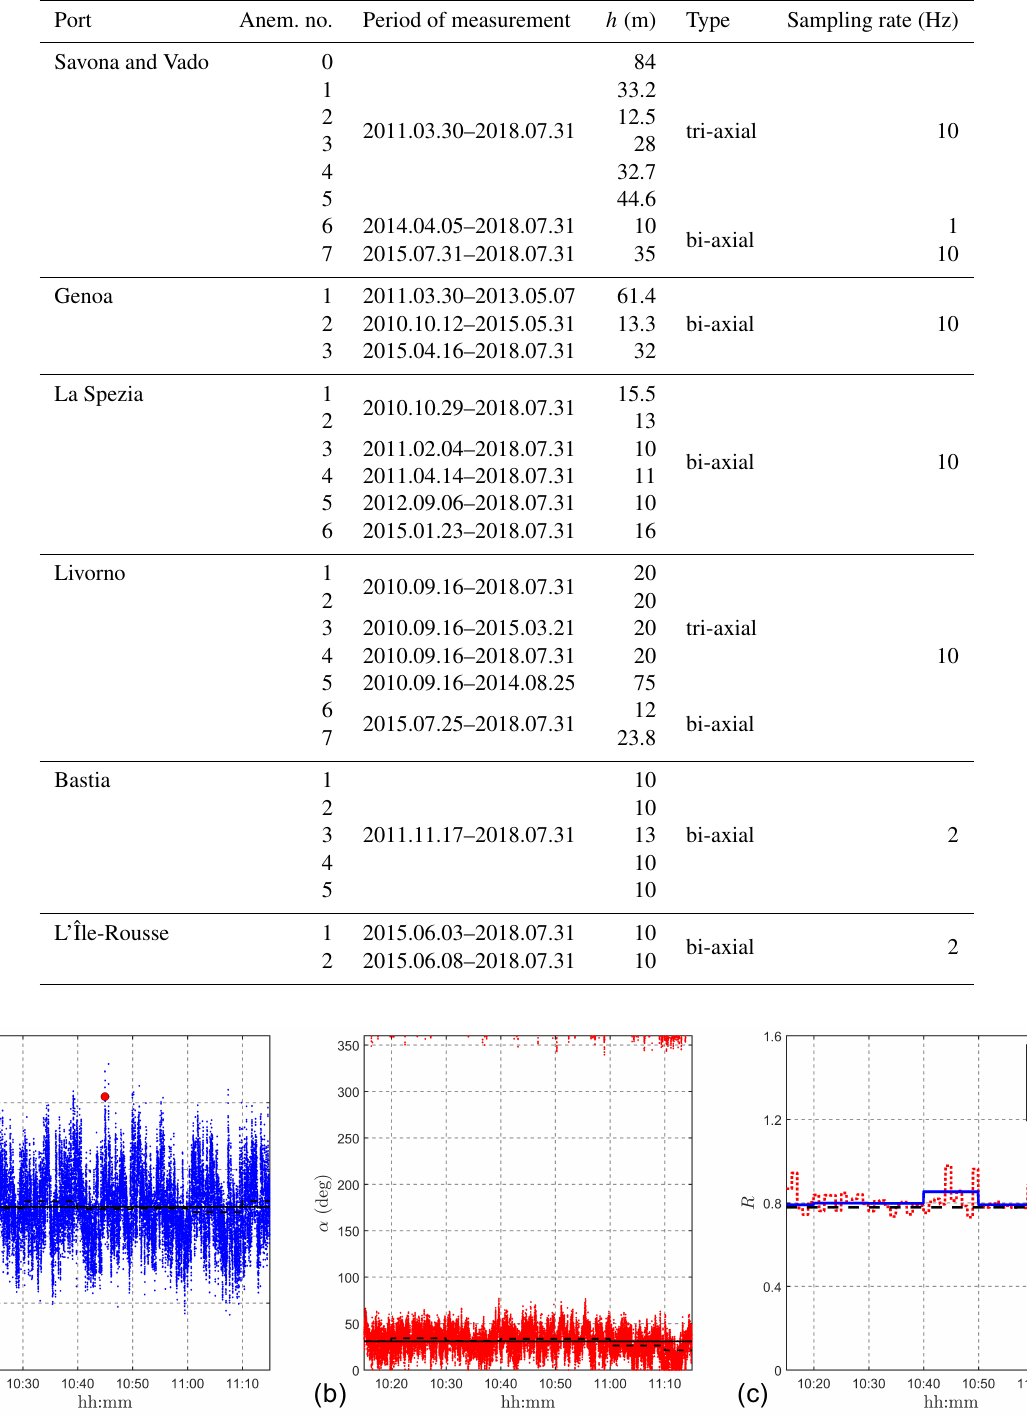
Table 1. Main properties of the WP and WPS monitoring network. The date format is yyyy.mm.dd.